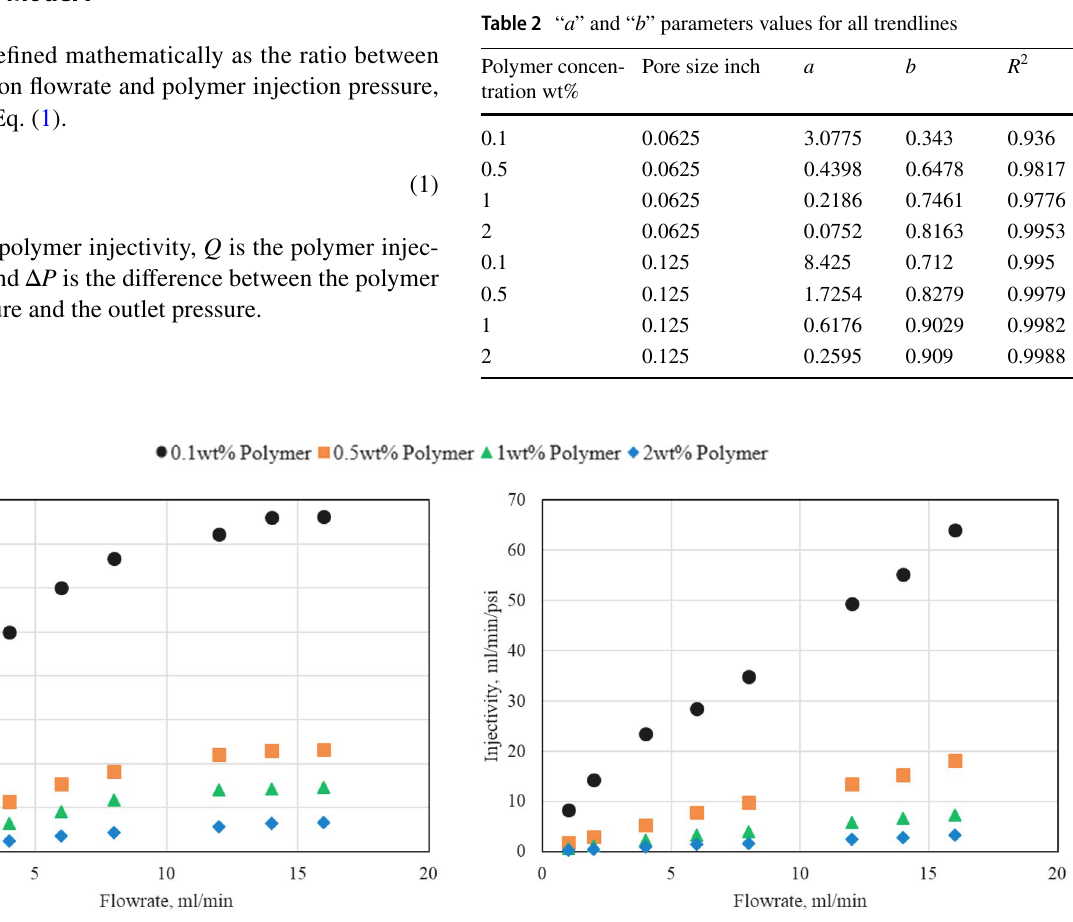
Fig. 2 Polymer injectivity at different flowrates for the a 1/16 inch and b 1/8 inch ID